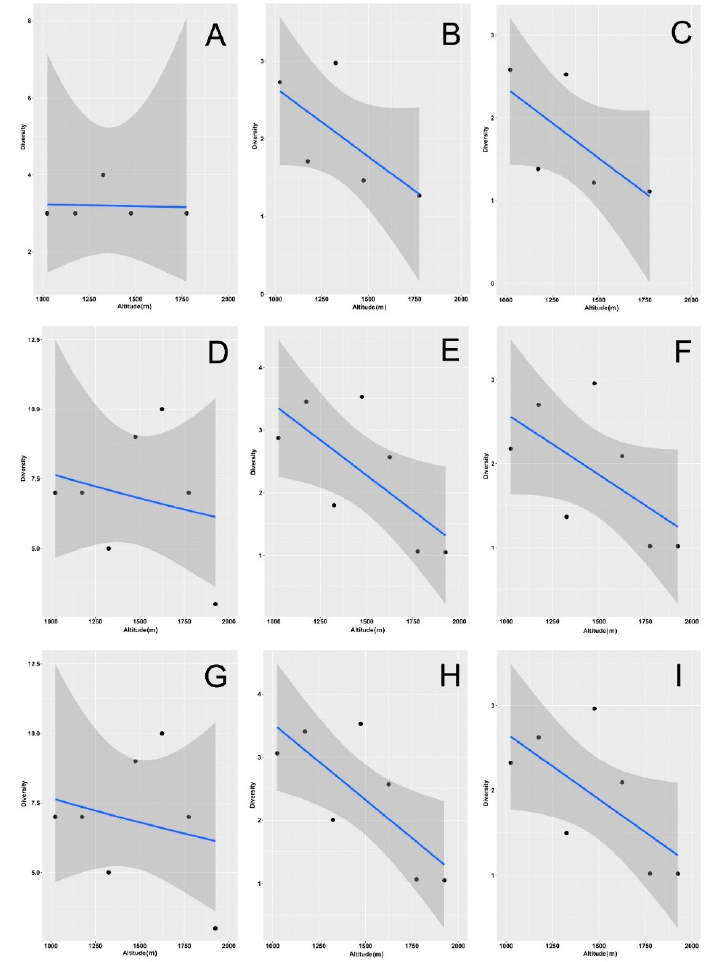
Figure 6. Relationship of scarabaeid species richness ( A , D , G ), exponential Shannon diversity ( B , E , H ), and Simpson diversity ( C , F , I ) and altitude along an elevational gradient in central Italy. Curves were constructed using empirical values for the two habitats (woodlands and grasslands) separately (woodlands: A – C ; grasslands: D – F ) and merged ( G – I ). General linear models were used for fitting. Dashed areas are 95% confidence